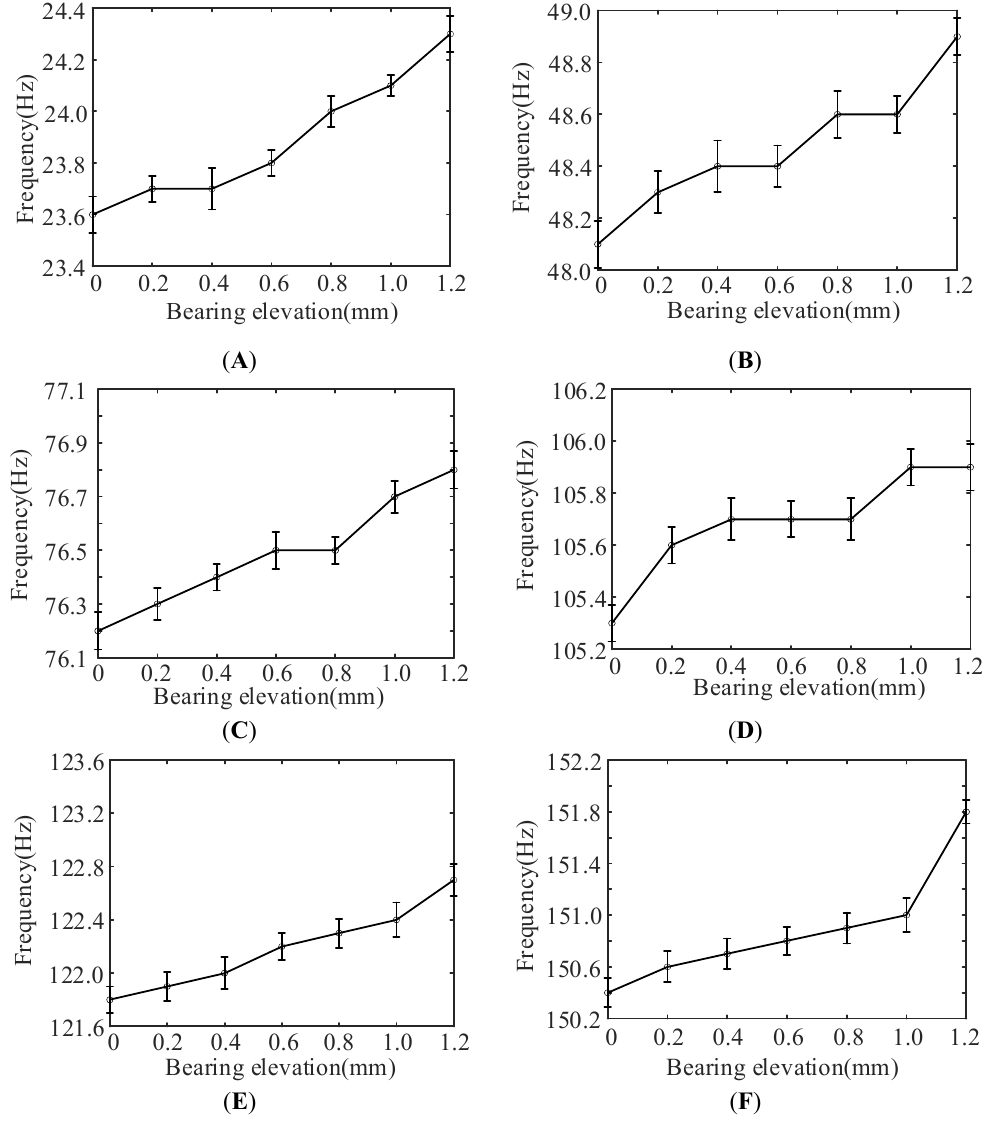
Figure 12. The change trend of the first six-order natural frequency: ( A ) First-order natural frequency; ( B ) Second-order natural frequency; ( C ) Third-order natural frequency; ( D ) Fourth-order natural frequency; ( E ) Fifth-order natural frequency; ( F ) Sixth-order natural frequency.